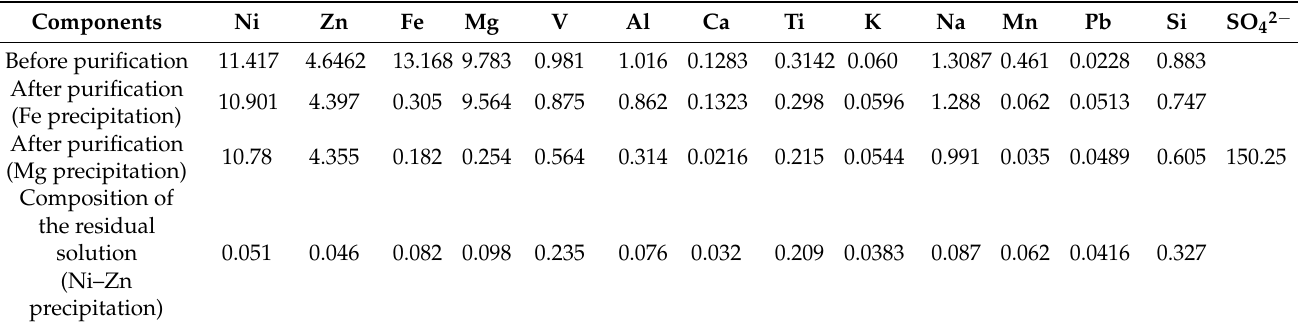
Table 4. Overall composition of the purified leachate before and after Fe and Mg precipitation